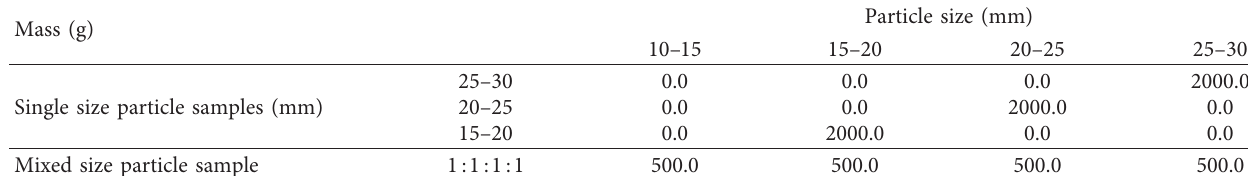
Table 1: Particle mass of different